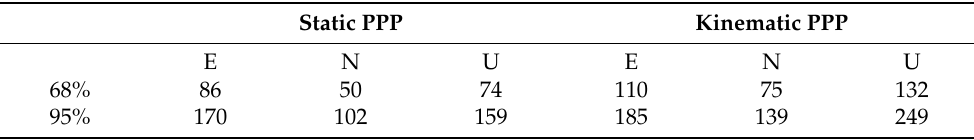
Table 4. Convergence time of the QF method (unit: min) (R). Static PPP